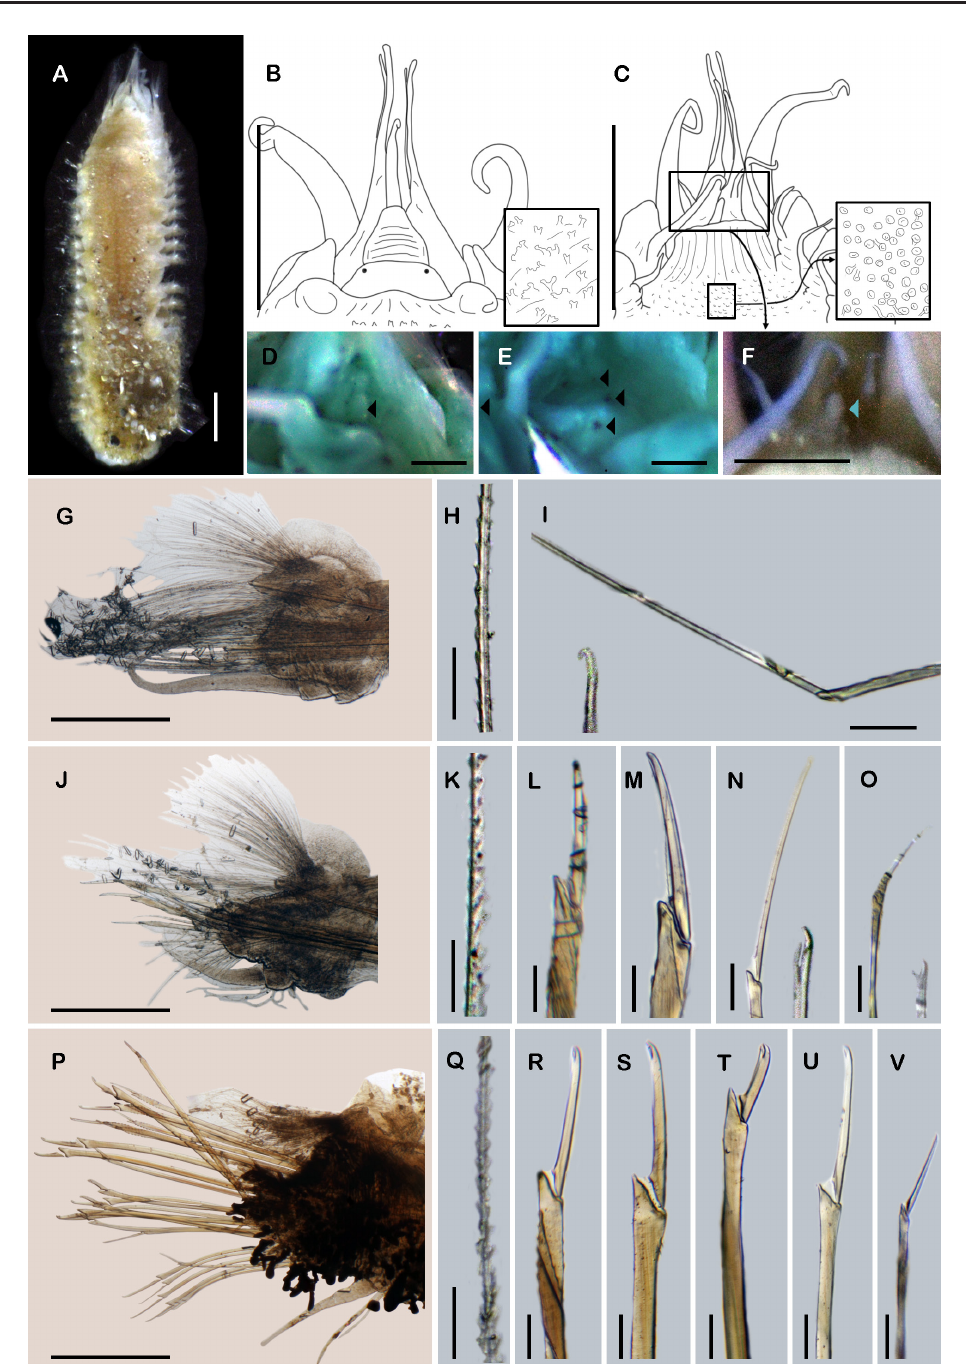
Fig. 7. Neopsammolyce floccifera (Augener, 1906), non-type material (UMML 6806-727). A . Incomplete worm, dorsal view. B . Anterior end, dorsal view (insert: dorsal papillae). C . Anterior end, ventral view (insert: ventral papillae). D . Anterodorsal section of prostomium, arrowhead indicates lateral antenna. E . Prostomium, arrowheads indicate the three pairs of eyes. F . Anteroventral view of prostomium, arrowhead indicate facial tubercle. G . Right parapodium from segment II. H . Notochaeta from same. I . Units A–D. J . Right parapodium from segment III. K . Notochaeta from same. L . Unit A. M . Unit B. N . Unit C. O . Unit D. P . Right parapodium from segment 43. Q . Notochaeta from same. R . Unit A. S . Unit B. T . Unit C. U . Subunit 2. V . Unit D. Scale bars: A–C = 1 mm; D–F = 200 μm; G, J, P = 500 μm; H, K, Q = 40 μm; I, L–O, R–V =